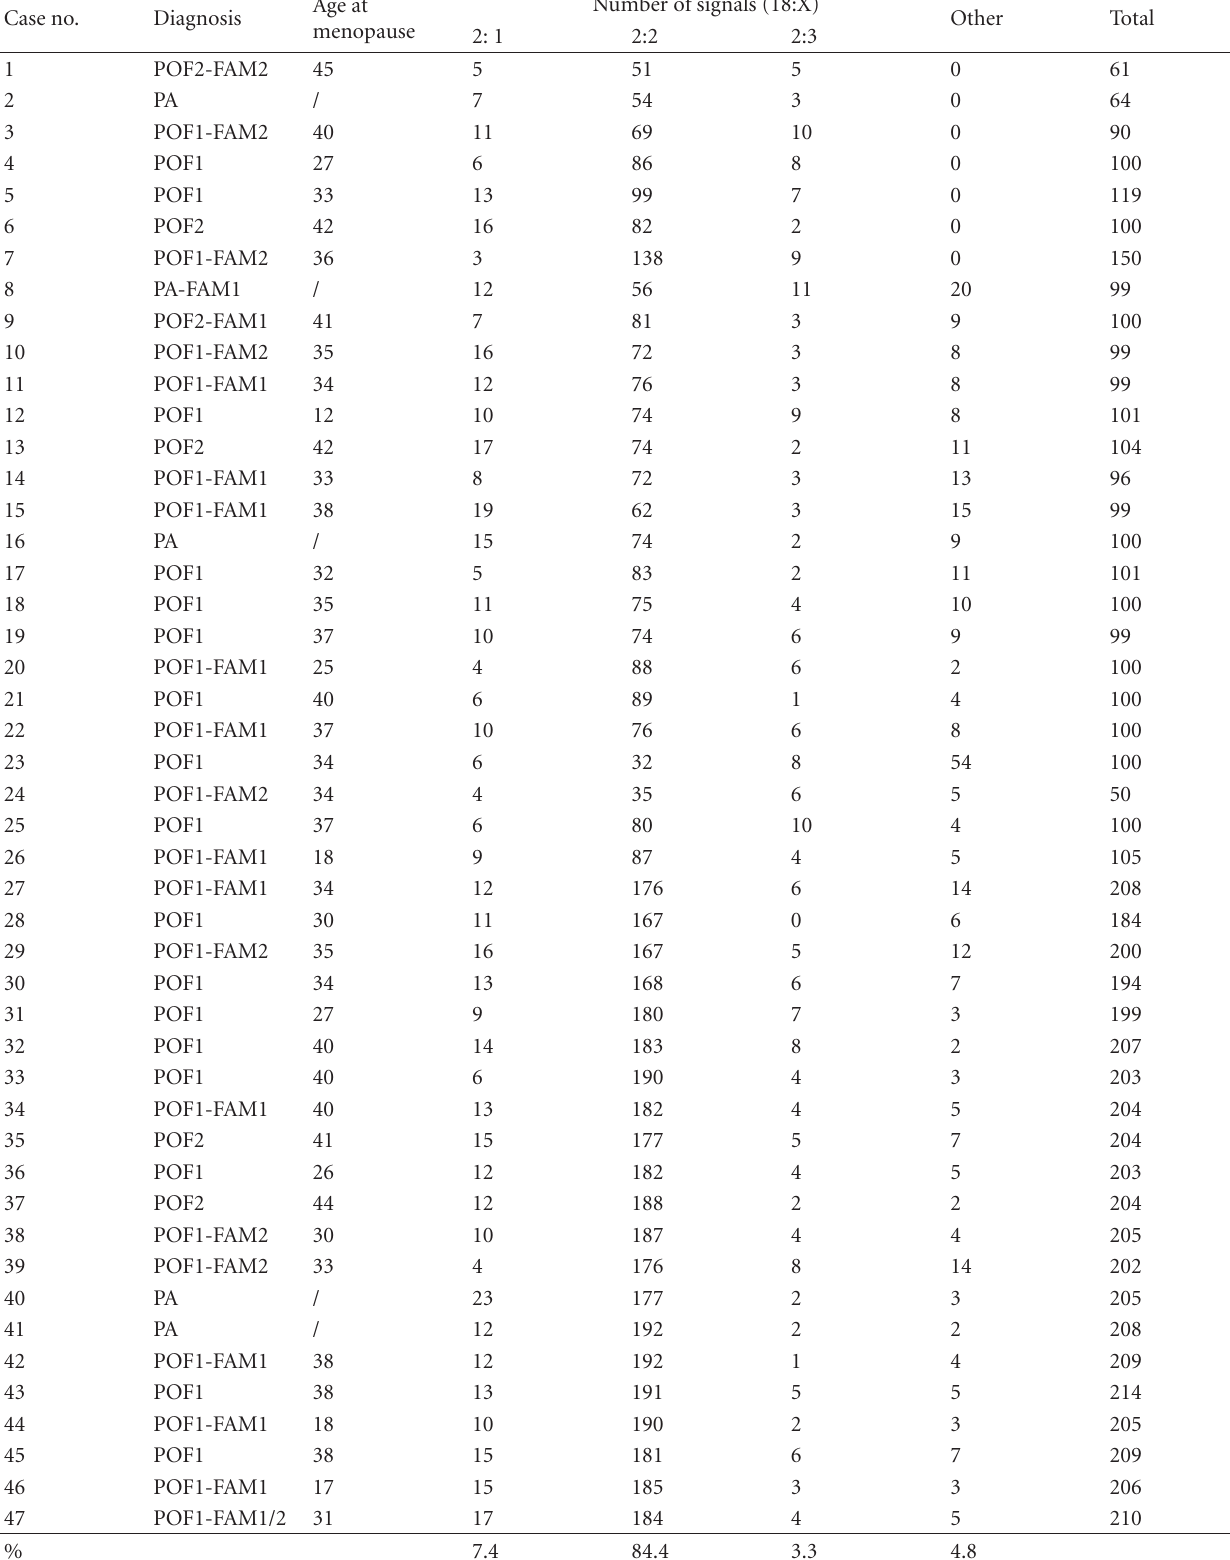
Table 2: Detailed list of 18:X chromosome signals found in the patient